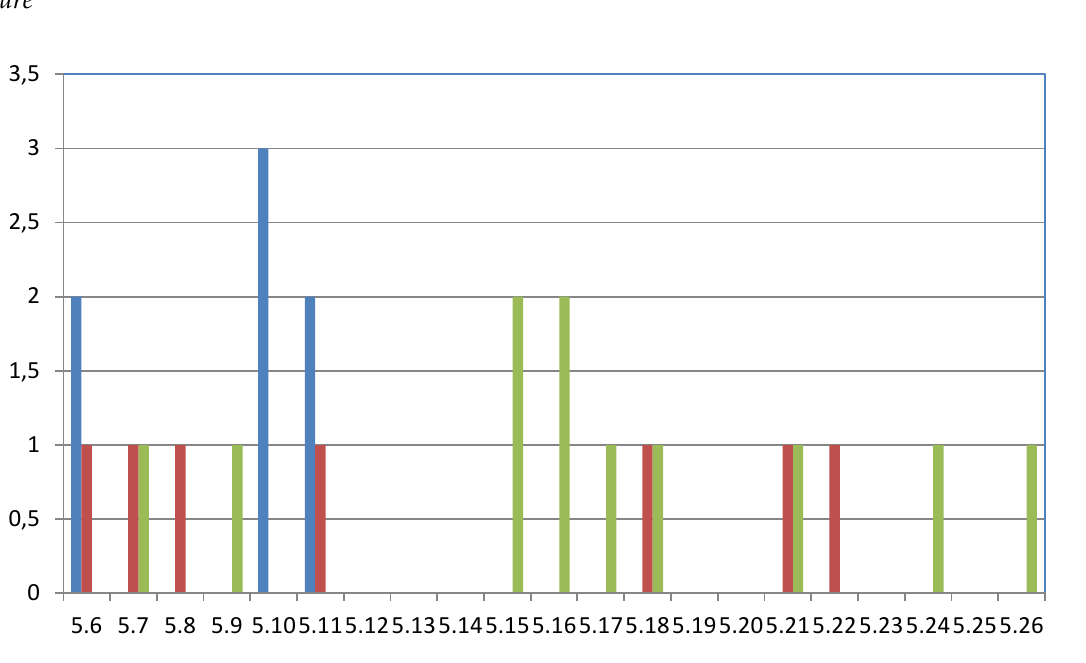
Figure 3: Dates of Postings and Categories from May 6 – May 26, 2012, Tsukuba Civic Activities Cyber- Square